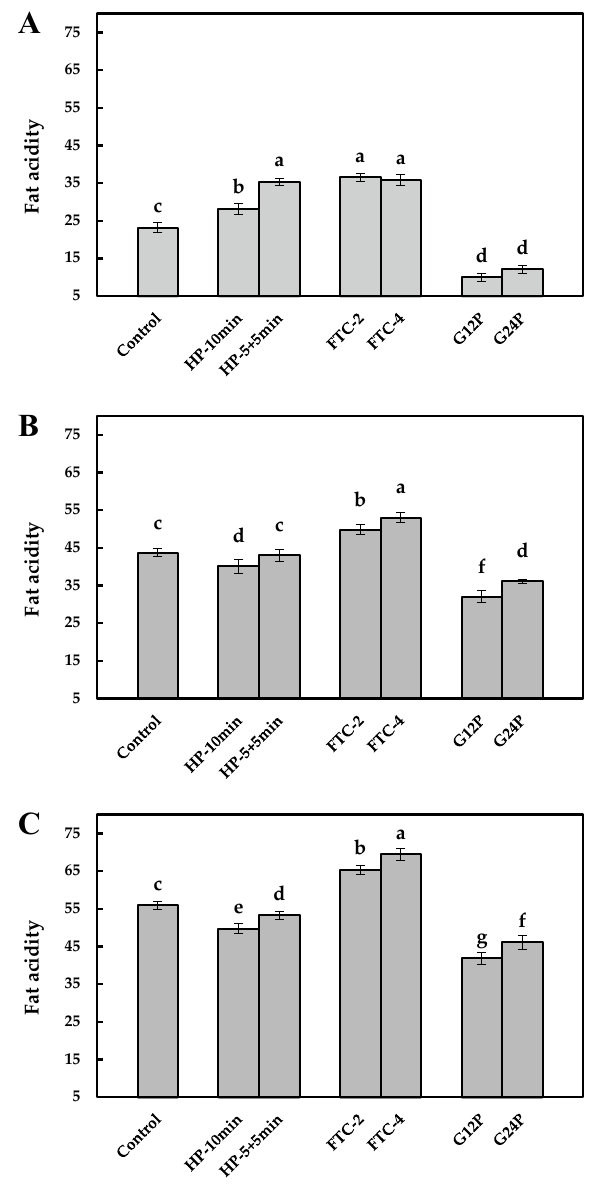
Figure 1. Fat acidity (mg KOH/100 g) of brown rice processed with different treatments after ( A ), 0 day; ( B ), 7 days; ( C ), 14 days of storage. Values are means ± standard deviations (n = 3). Different letters indicate significant differences ( p <